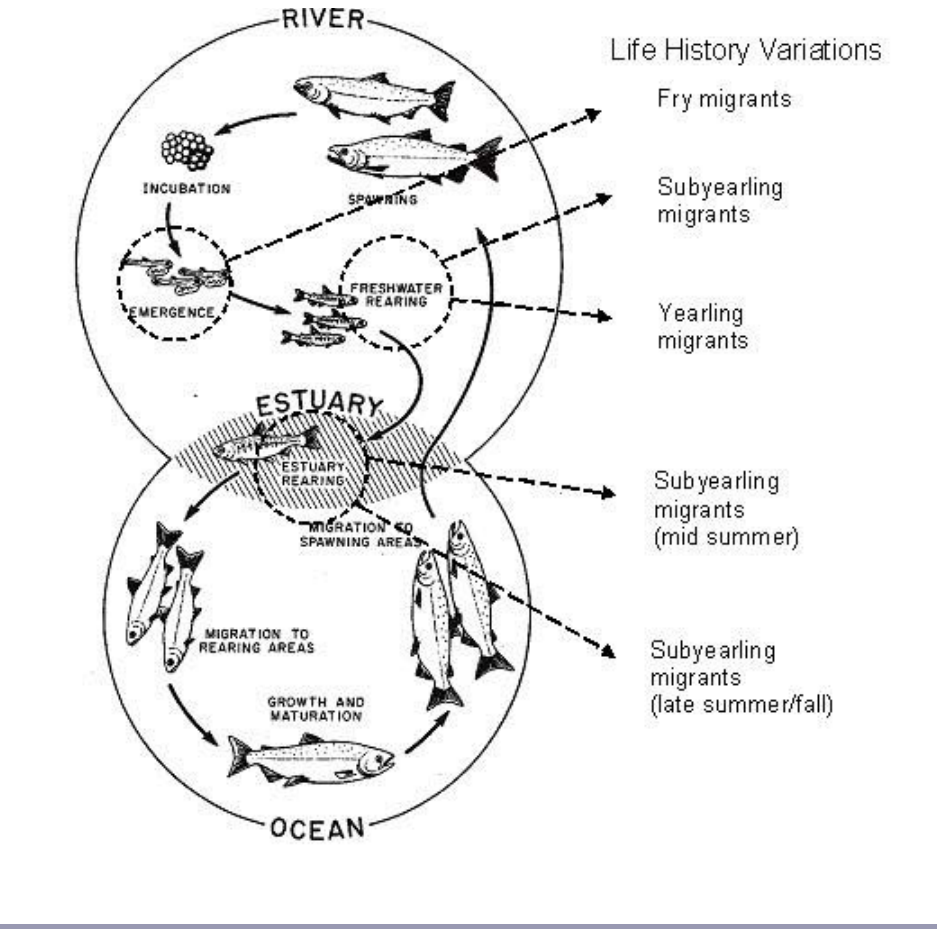
Fig. 1. Generalized Chinook salmon life cycle and the associated environments of the salmon ecosystem. Salmon may complete their life cycles through a variety of alternative pathways, illustrated here by five juvenile life-history types reported in Sixes River, a small coastal watershed in southwest Oregon (Reimers 1973). Each life-history type represents a different pattern of freshwater or estuarine residency before ocean migration. Figure adapted from Nicholas and Hankin